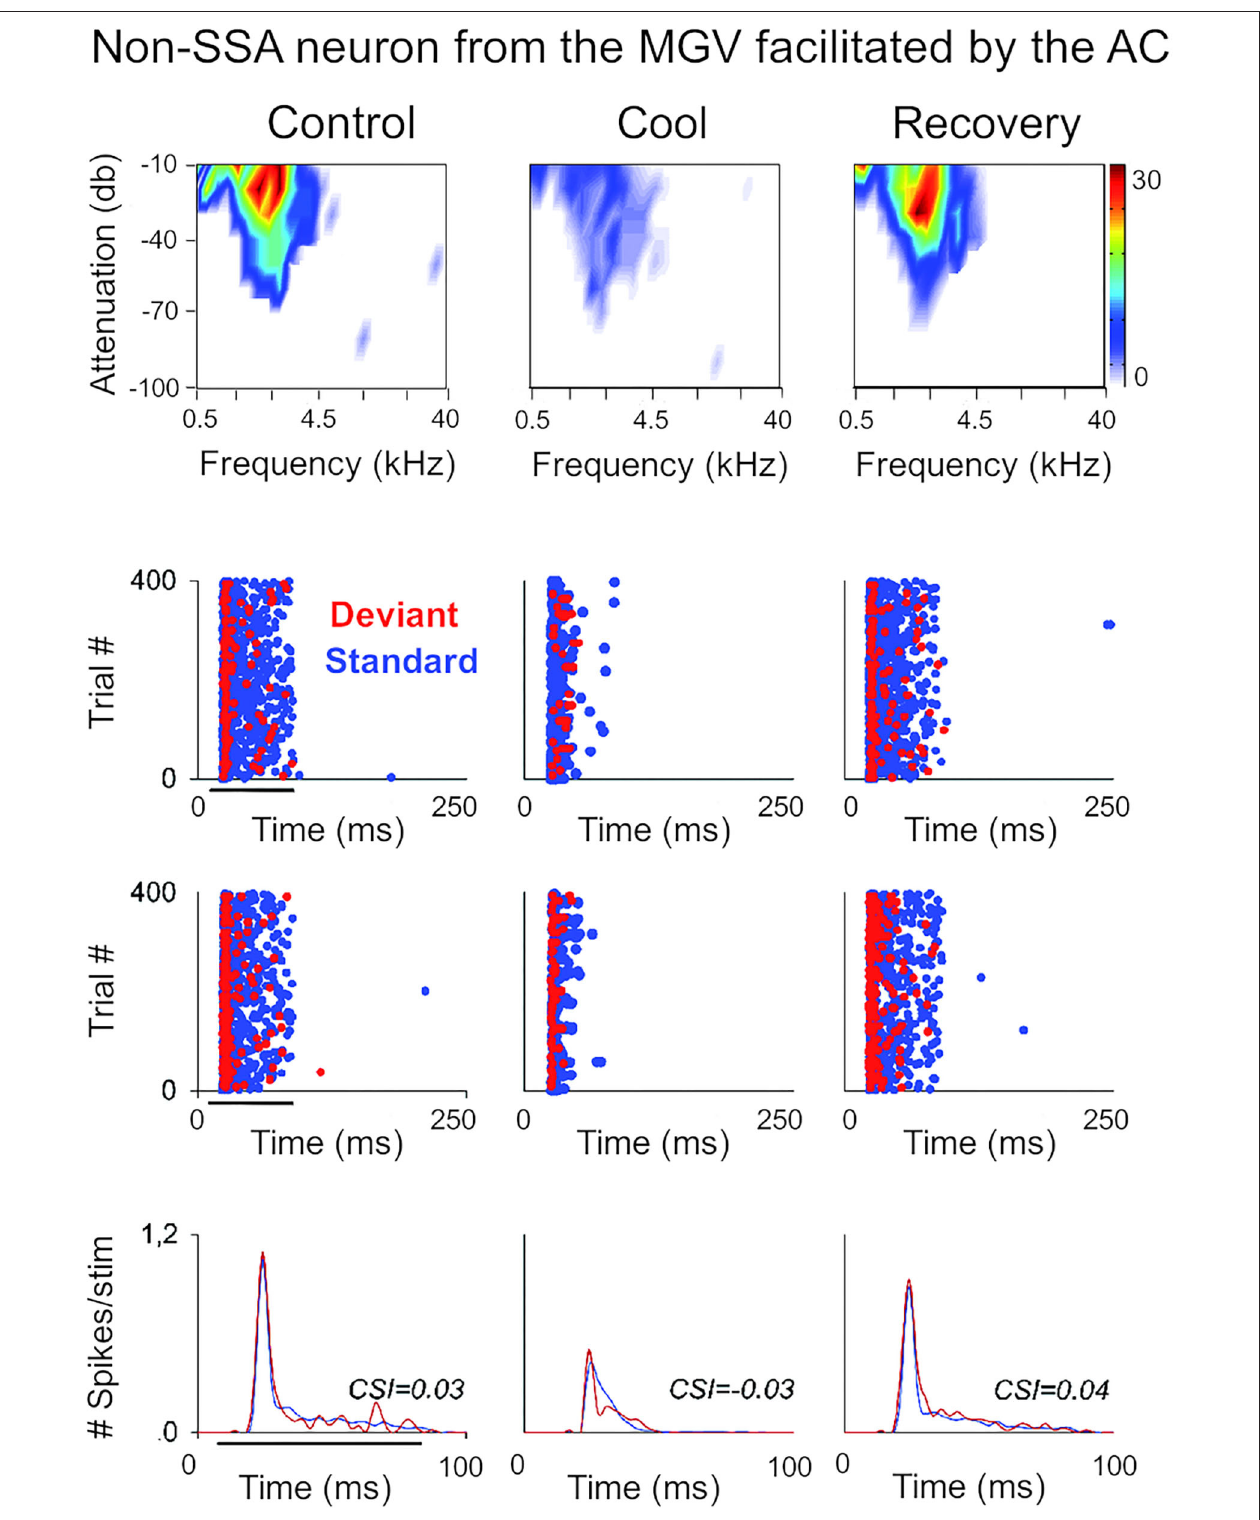
FIGURE 3 | Non-SSA neurons primarily receive facilitatory influences from the AC. Example of a neuron recorded from the MGV that was facilitated by the AC, presented as in Figure 2 . The neuron responds consistently to both the standard and the deviant over the trials, i.e., it does not show SSA as confirmed by the low CSI value ( ∼ 0). The CSI value was not significantly changed by AC deactivation. AC, auditory cortex; MGV, ventral subdivision of the medial geniculate body; CSI, common SSA index. Adapted from Antunes and Malmierca (2011).